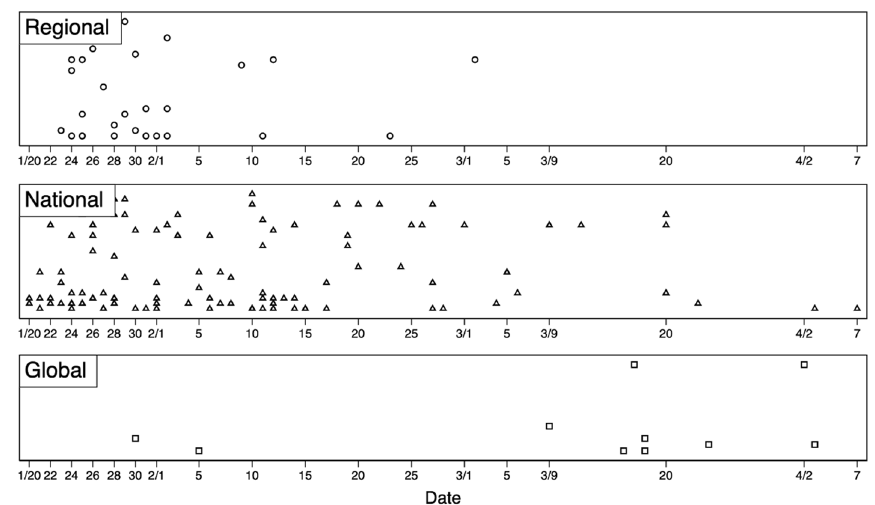
Fig. 3 Trend of the geographic coverage of new scenario beneficiaries by